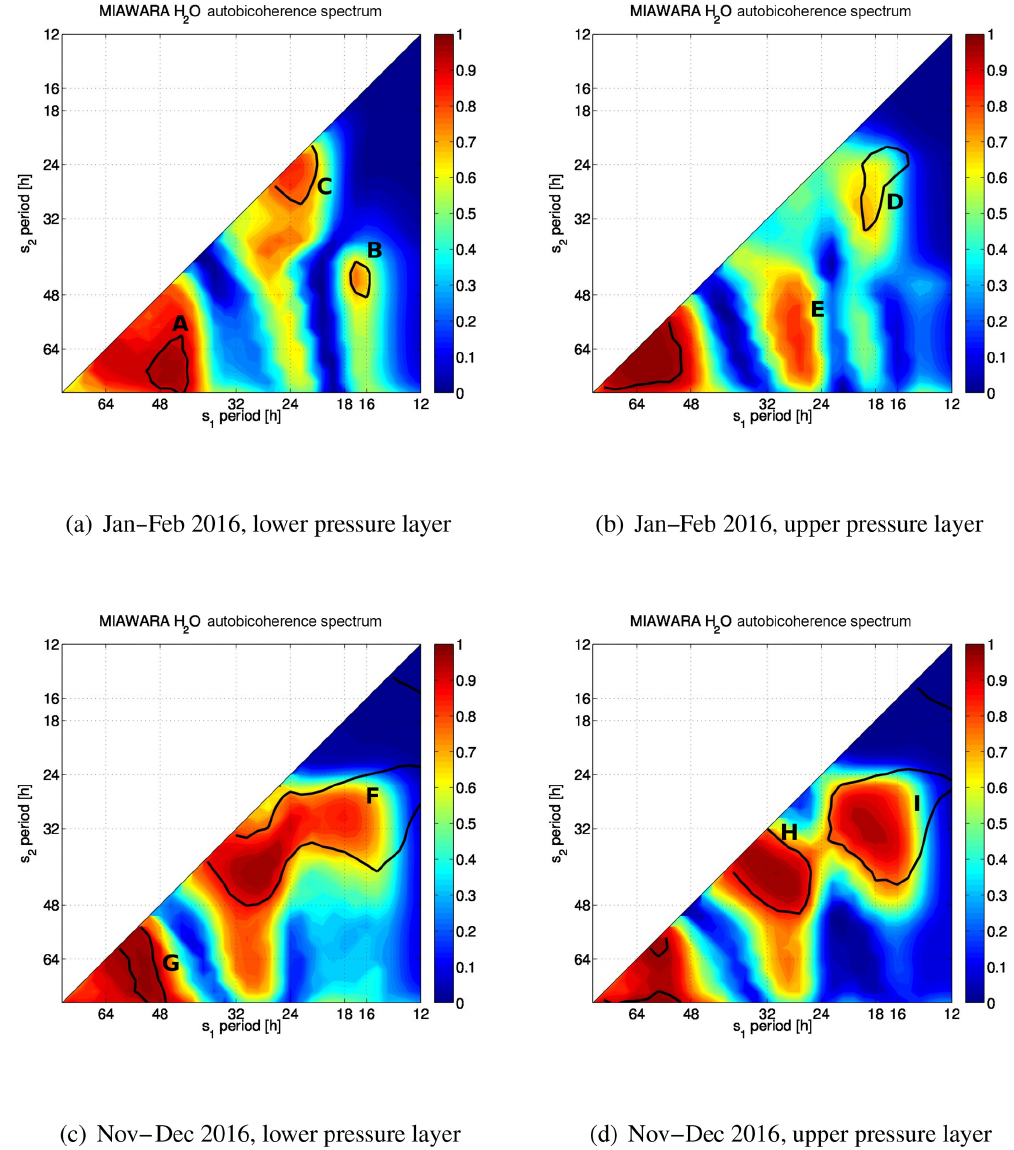
Figure 9. Wavelet-based autobicoherence spectrum from pressure-layer-averaged MIAWARA water vapor time series with individual lengths of 2 months. The chosen pressure layers are 0 . 05–0 . 2 and 0 . 2–1hPa. Thick contours enclose regions of 80% point-wise confidence after controlling the FDR (false detection rate). The diagonal line separates the two-dimensional spectrum into two symmetric regions. Interesting features on the plots are labeled with capital letters